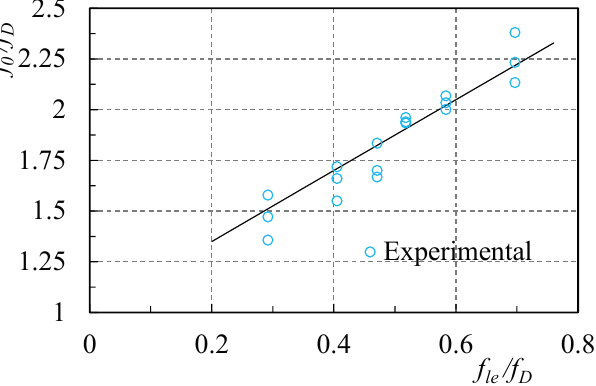
Figure 16. Parameter E 2 -experimental calibration with concrete cylinders confined with GFRP tubes and SR.